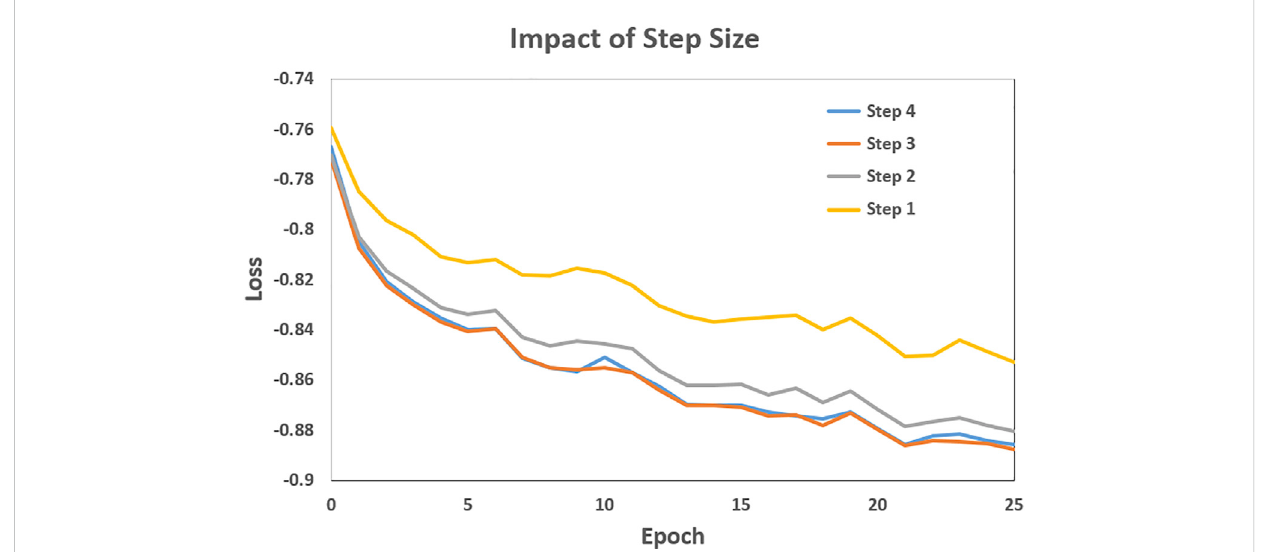
FIGURE 10 The plot of training loss versus epoch demonstrates the neural network performance with changing step sizes from 1 to 4. The network learned faster with increasing step size but saturated at step size 4 for the dataset used.